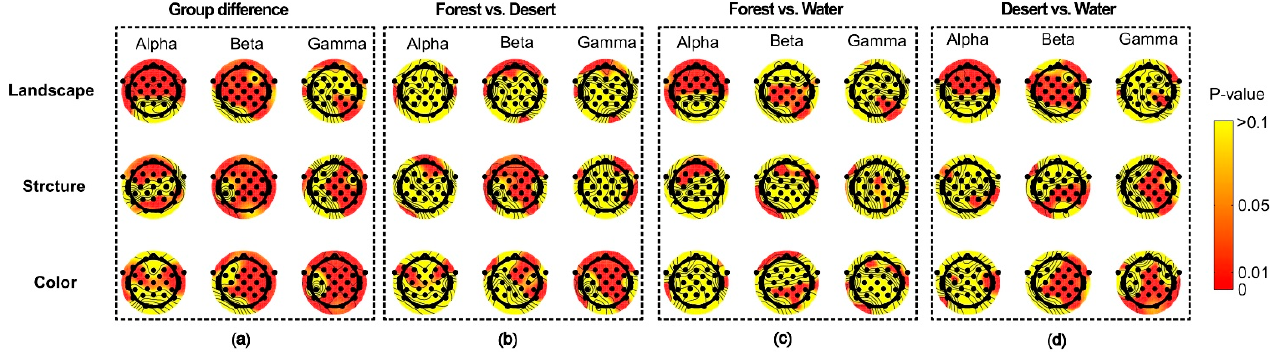
Figure 7. The difference in distribution of brain waves for alpha and beta waves among landscapes in different scenarios. ( a ) the group differences among different scenarios, ( b ) the difference between forest and desert, ( c ) the difference between forest and water, ( d ) the difference between desert and water.